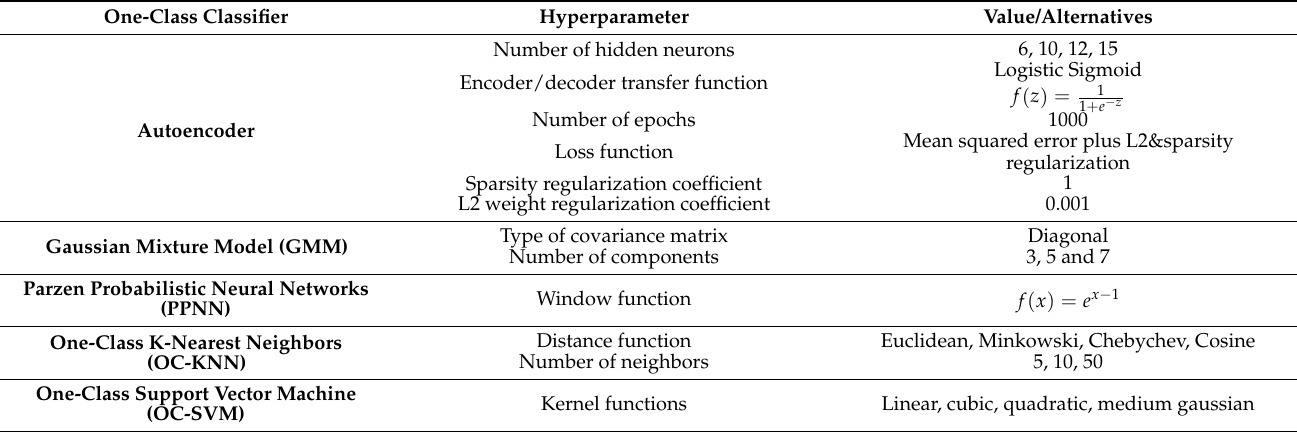
Table 3. Values and alternatives of the hyperparameters utilized for the evaluated models of the classifiers.